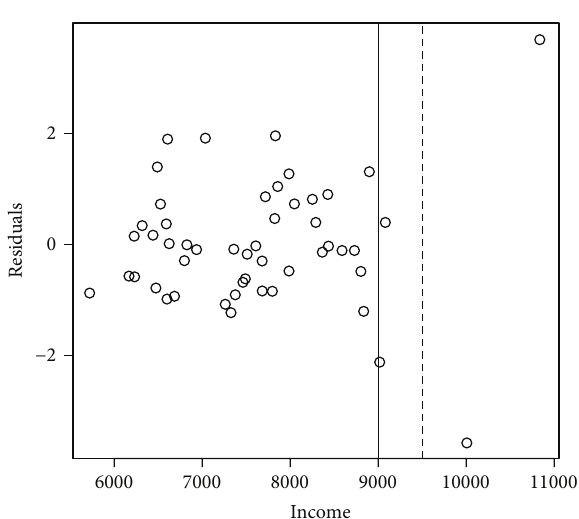
Figure 2: (a) Most likely cluster given by 𝜆 . (b) Most likely cluster given by